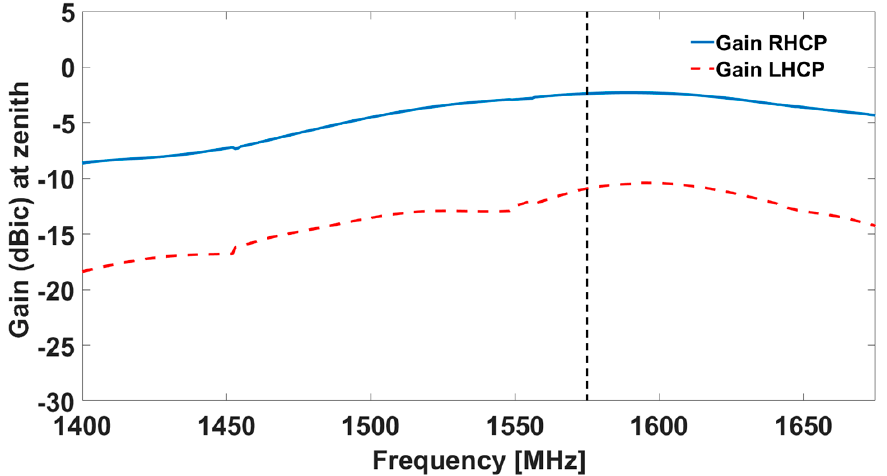
Figure 8. Gain as measured in the CTR chamber for one of the lateral antennas: the solid line is the RHCP, while the dotted line is the LHCP.